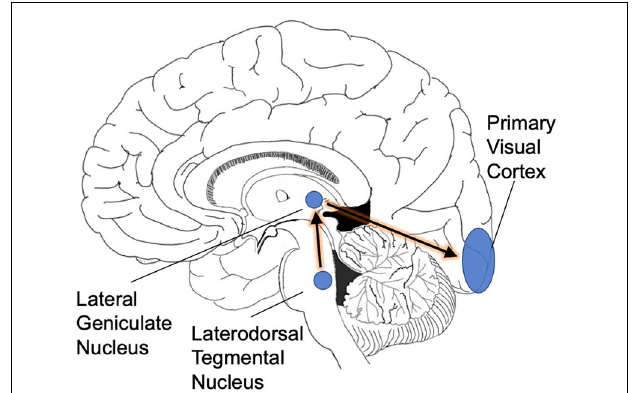
FIGURE 1 | PGO waves. As a prelude to REM sleep, waves of activity move from the brainstem into the occipital cortex. We suggest that this infusion of activity is necessitated by the rotation of the planet into darkness: the visual system needs extra cyclic activation to keep its territory intact.